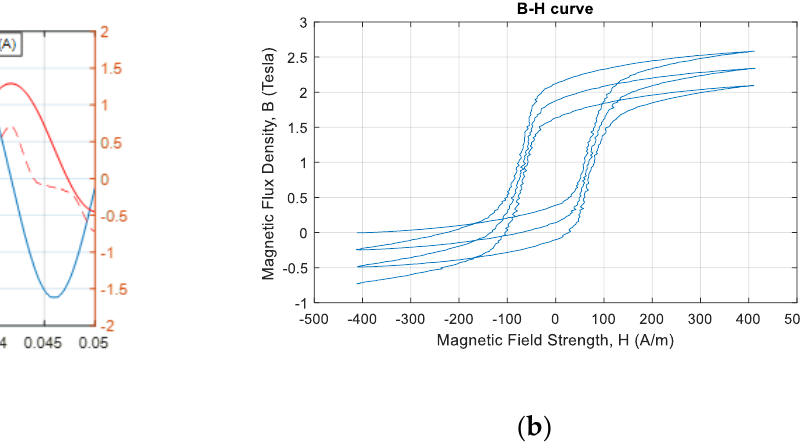
Figure 8. Effects of DC components of a voltage signal. ( a ) Voltage integration shifting downward with time. ( b ) B – H curve with multiple loops.